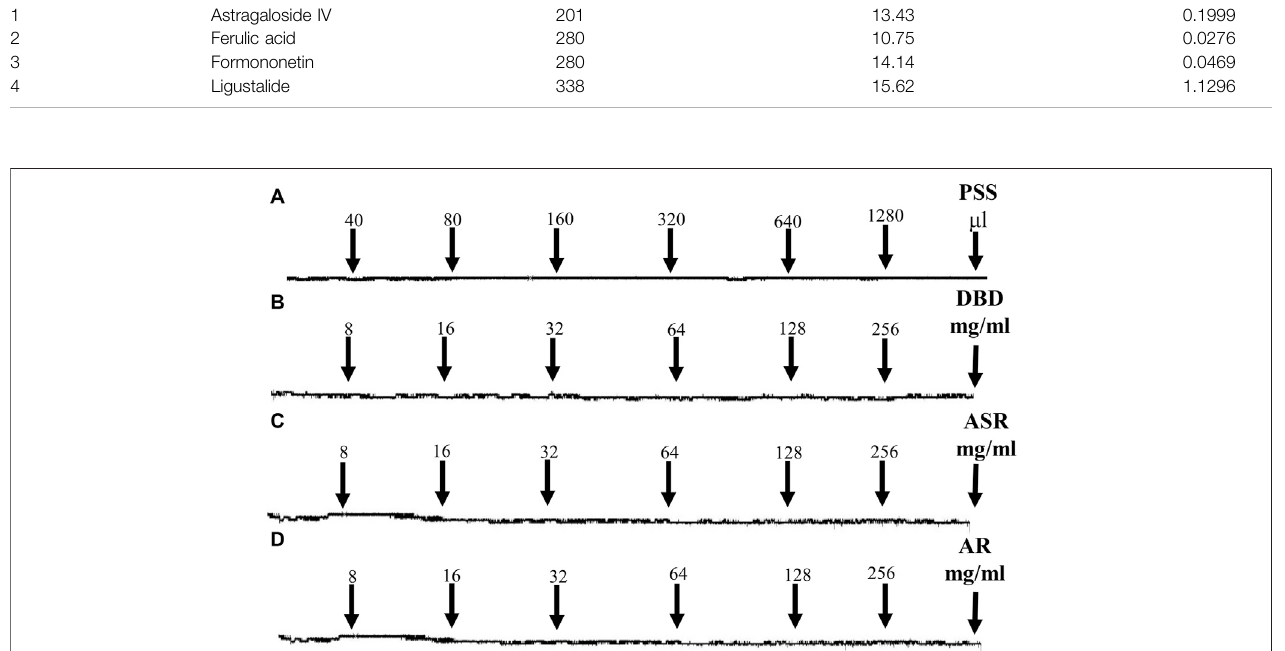
TABLE 1 | Contents of astragaloside IV, ferulic acid, formononetin, and ligustalide in lyophilized powder of DBD identi fi ed by HPLC analysis. NO.